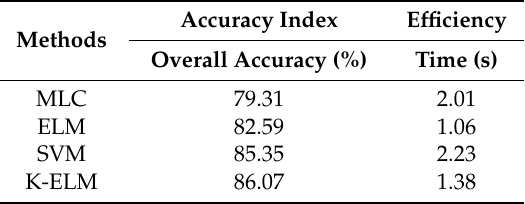
Table 3. Overall accuracy and efficiency assessment of the four methods.